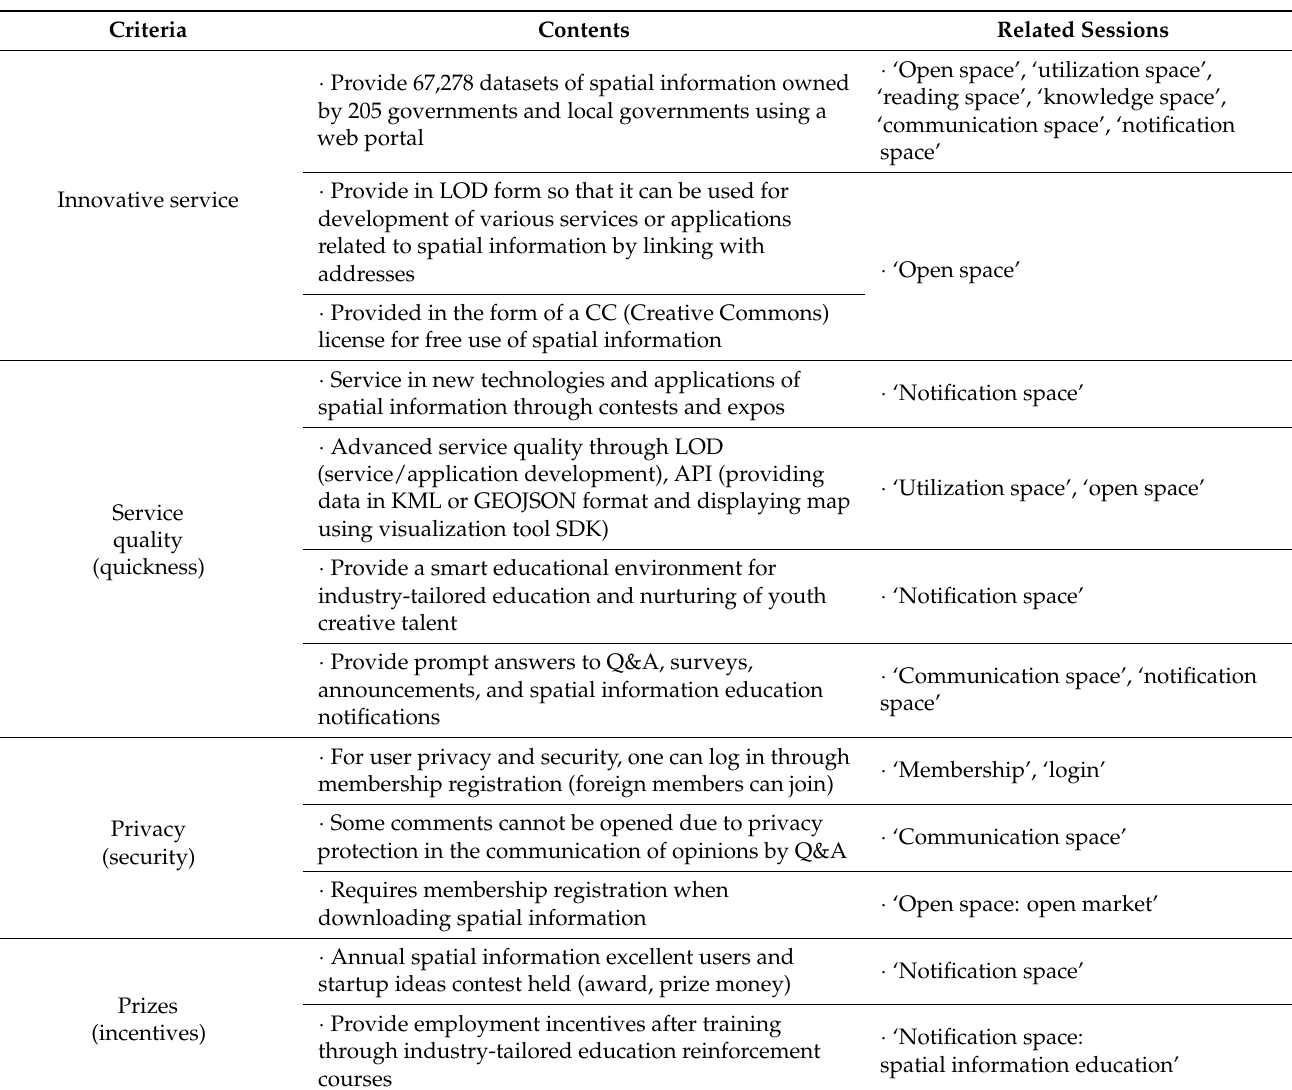
Table 4. NSDIP evaluation of civil petition